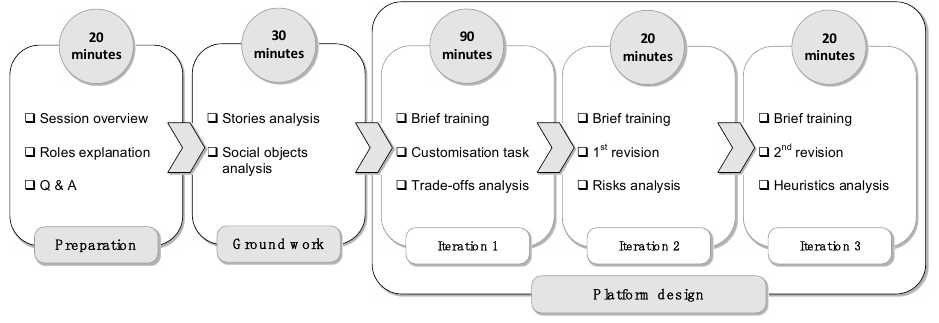
Figure 2. Case study second phase protocol.